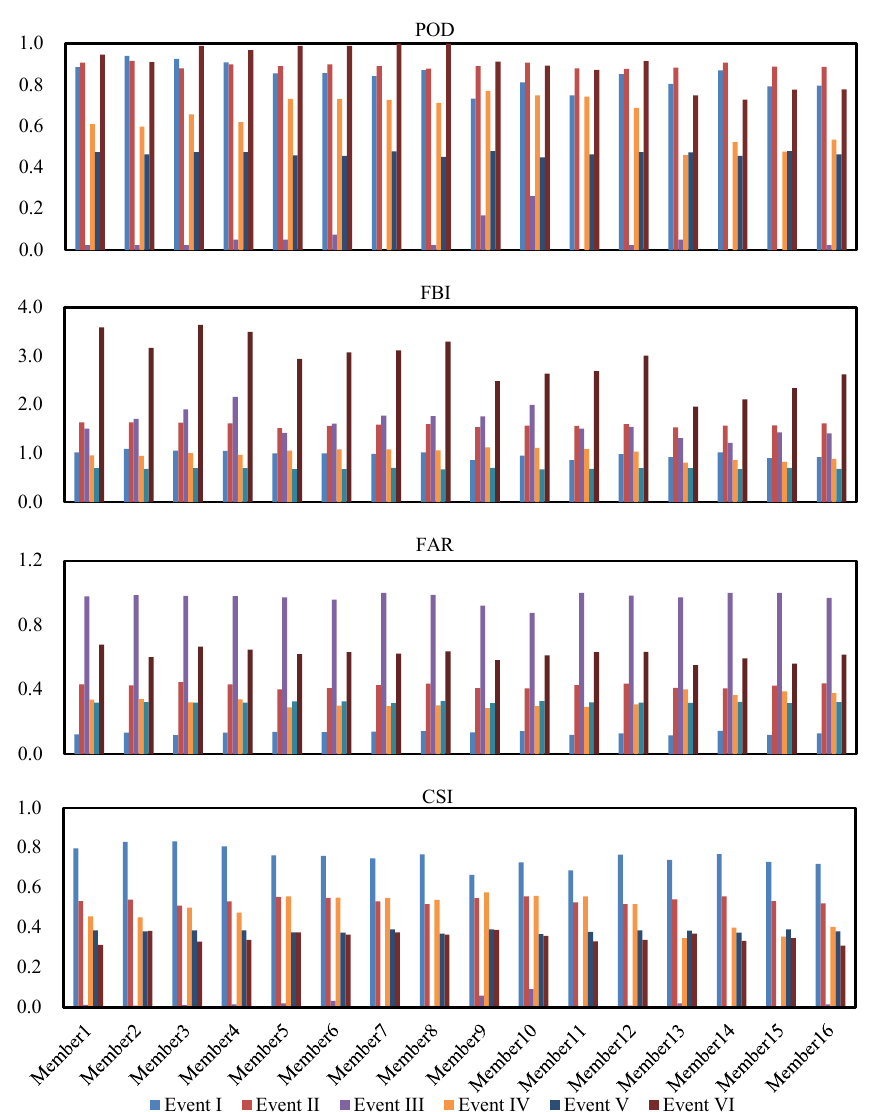
Figure 4. Spatial values of the four categorical indices for different storm events with the 16 members of the physical ensemble.